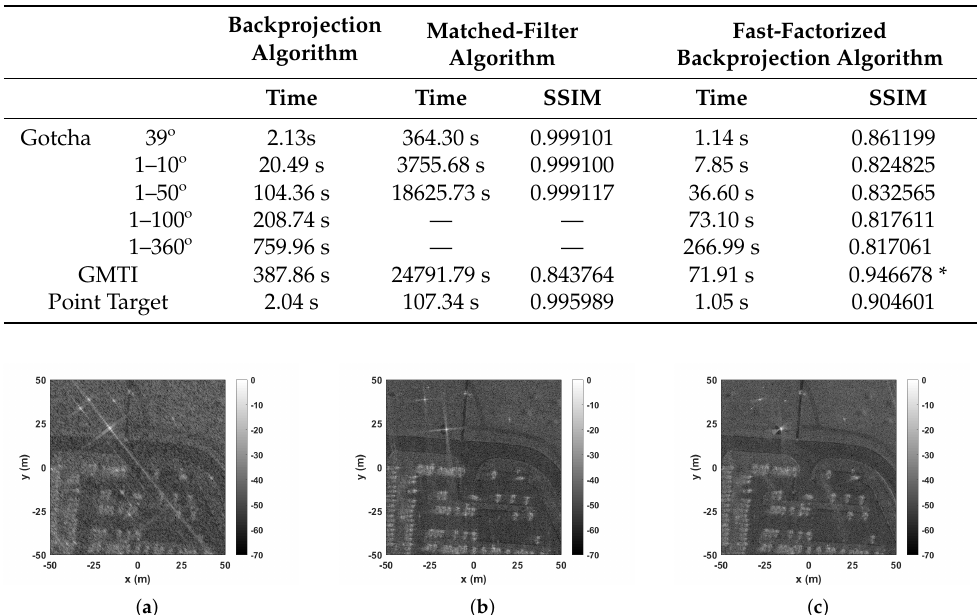
Table 5. Execution times and SSIM values of the images generated by the backprojection algorithm, matched filter algorithm, and fast-factorized backprojection algorithm. The SSIM values were obtained in comparison with the backprojection algorithm images, which is why the algorithm does not have a value. The asterisk in the fast-factorized backprojection image indicates that the SSIM value of the GMTI was obtained compared with the image the matched filter algorithm generated, instead of the backprojection. This is due to the differences in the algorithm implementations, where the backprojection leaves dark triangles in the corners, while the other two algorithms leave an extremely unfocused area. Since the unfocused is more similar, the comparison is assumed to be fairer this way. Backprojection Matched-Filter Fast-Factorized Algorithm Algorithm Backprojection Algorithm